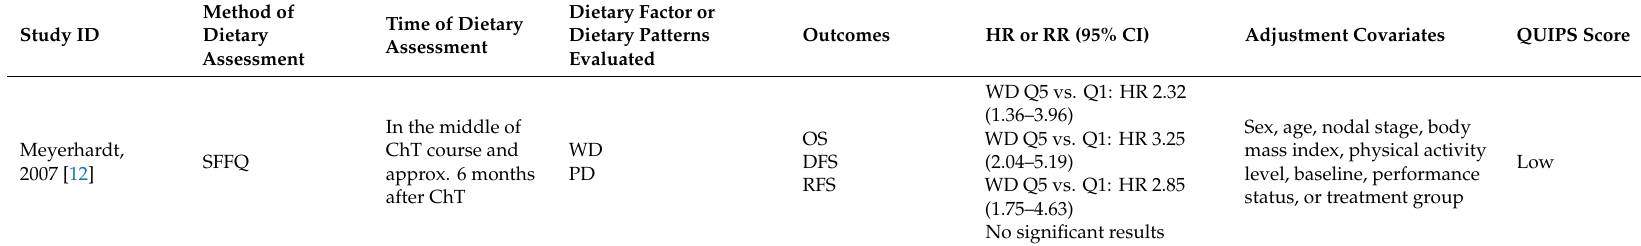
Table 3. Summary of results of included studies regarding colorectal cancer. Statistically significant ( p < 0.05) results (HR or RR; 95% CI) are